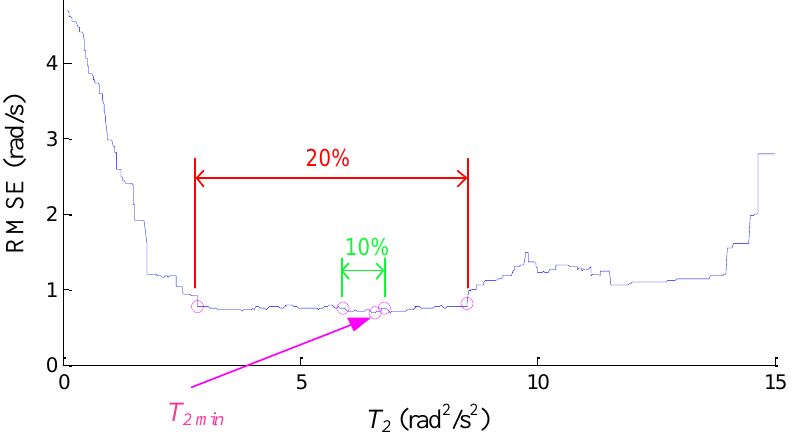
and the RMSE between  2